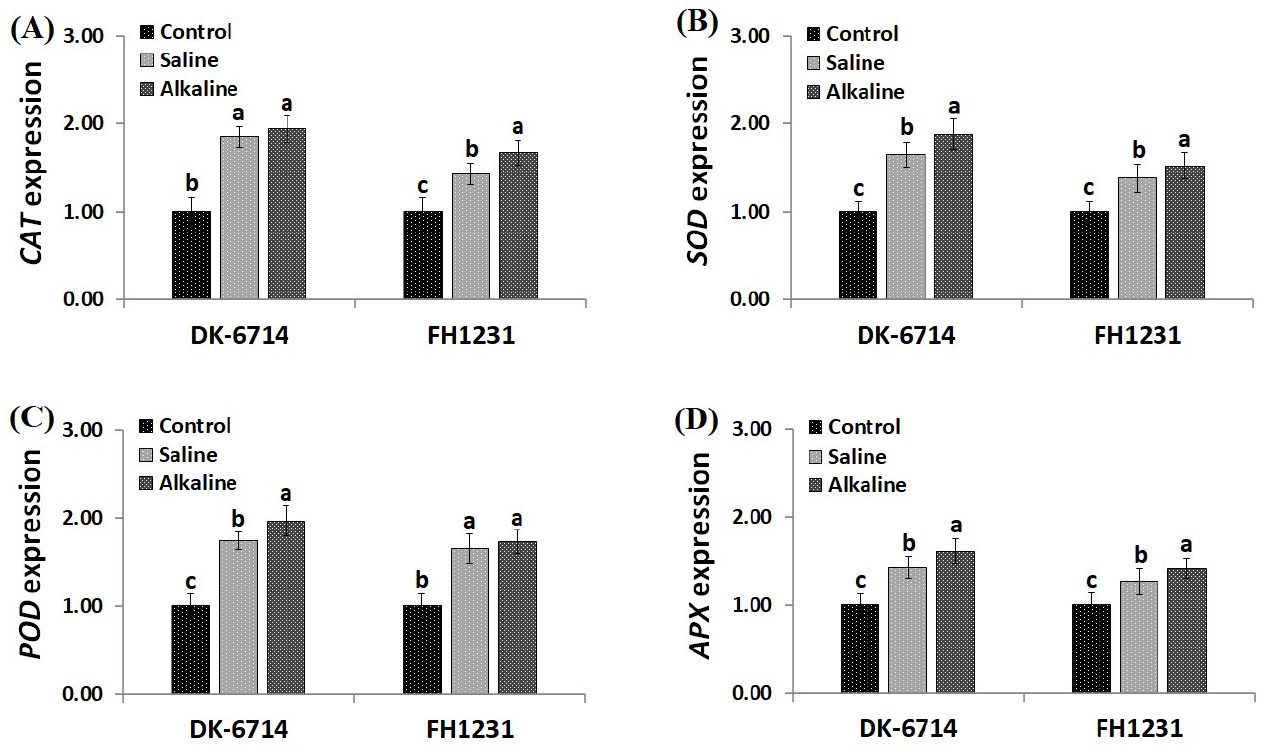
Figure 7. Effect of salinity and alkalinity stress on the expression levels of ( A ) the catalase ( CAT ) gene, ( B ) the superoxide dismutase ( SOD ) gene, ( C ) the peroxidase ( POD ) gene, and ( D ) the ascorbate peroxidase ( APX ) gene in 20-day-old maize seedlings of two hybrids (DK-6714 and FH-1231). The bars represent the standard error (SE) of three replicates. Similar small letters above bars represent nonsignificant (ns) differences among treatments ( p ≤ 0.05).